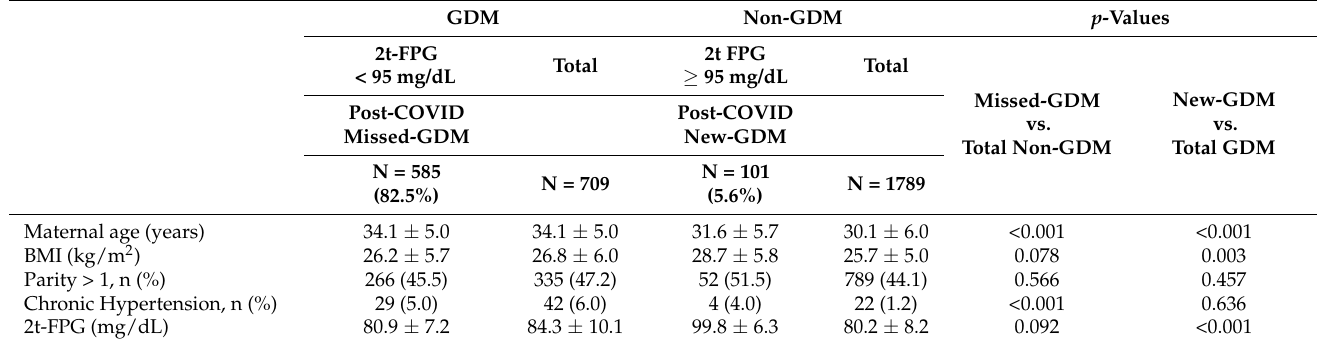
Table 4. Maternal characteristics and perinatal outcomes in pregnant women with gestational diabetes mellitus diagnosed at 24–28 weeks of pregnancy (GM) and with normal glucose tolerance during pregnancy (Non-GDM), according to the two-step diagnosis (18) and in pregnant women with missed and new GDM based on the recommendations of Spain (4) for GDM diagnosis during the